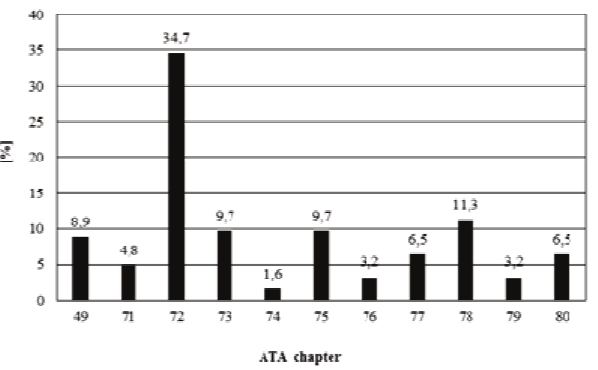
Fig. 27. Share of turbojet engine system events coded by ATA 100 chapter between 2008 and